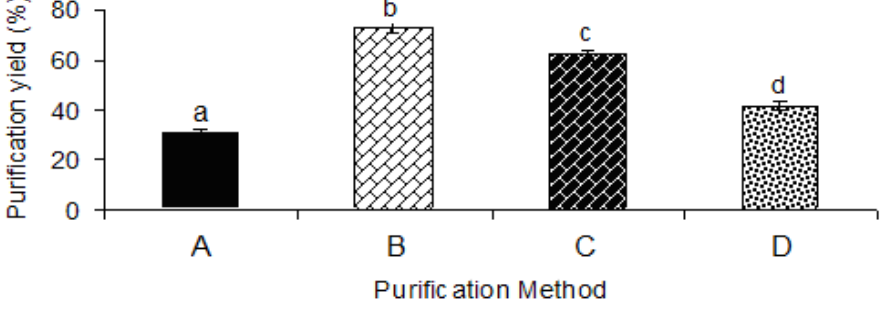
Figure 1. Effect of different purification methods on the purification yield. A, isopropanol and ethanol; B, isopropanol and acetone; C, saturated barium hydroxide; D, Fehling